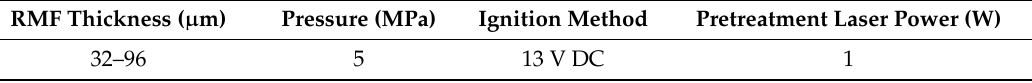
Table 1. Reactive multilayers joining parameters.